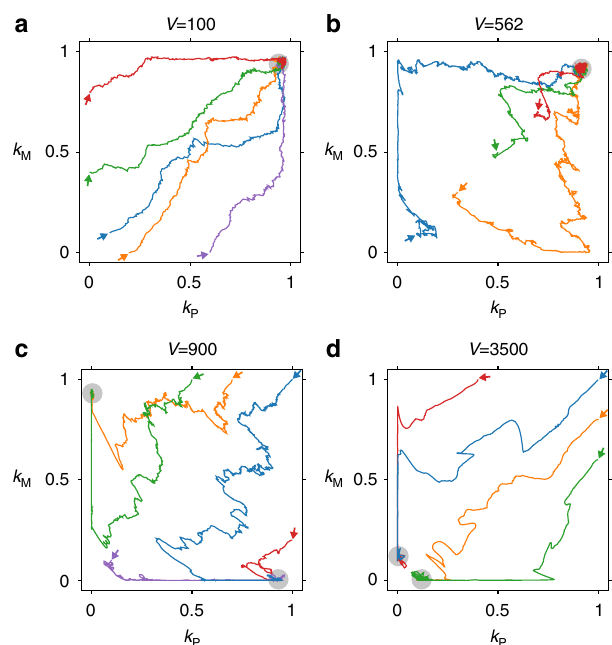
Fig. 4 Evolutionary trajectories of the catalytic activities of the plus and minus strands ( k P and k M , respectively). The values of k P and k M were averaged over all replicators at each time point. The arrows indicate different initial conditions; grey circles indicate equilibria. The values of V are shown above each graph: a. V = 100; b. V = 562; c. V = 900; d. V = 3500. The other parameters were the same as in Fig. 2. The data were obtained with the model in which kinetic symmetry is imposed (i.e., k PP = k PM and k MP = k MM ) so that evolutionary trajectories can be depicted in a